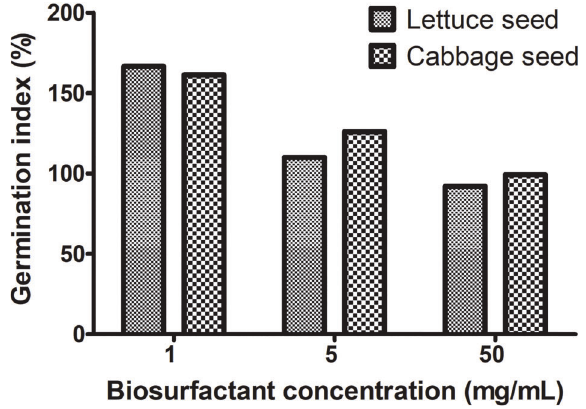
Figure 7. Effect of phytotoxicity of Streptomyces sp . biosurfactant on the seeds of lettuce and cabbage.